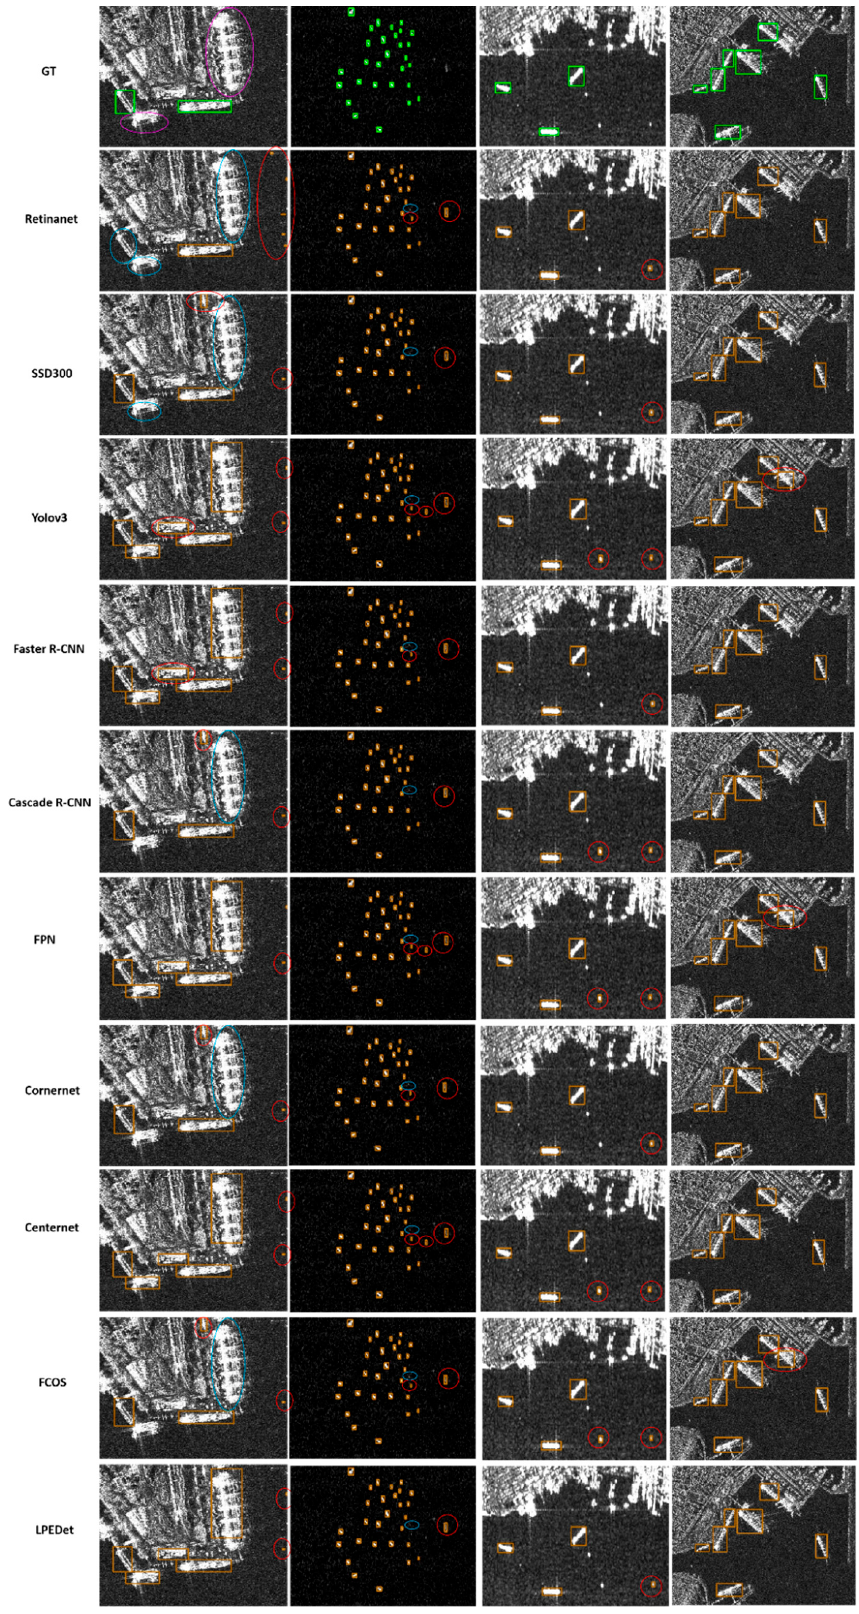
Figure 7. Visual detection results of the latest methods. The purple box is the target that was missed when marked, the red box is the target of misdetection and the blue box is a missed target.